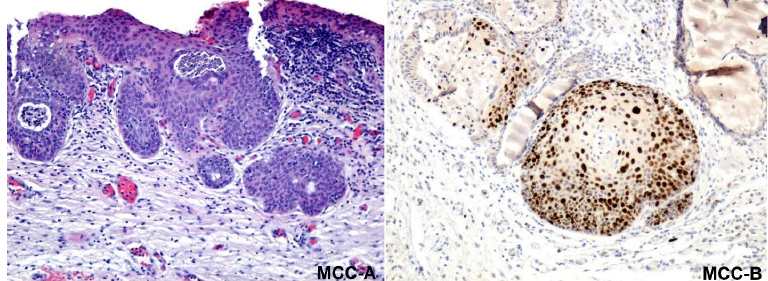
Figure 9. Microscopic aspects of microinvasive cervical cancer. MCC-A: non-keratinized stratified squamous epithelium with severe dysplastic lesions in all the tissue layers and the existence of a microinvasion island beyond the epithelial basement membrane is observed. The neoplastic cells invade the stroma, in one or more sites, to a depth of ≤ 3 mm below the base of the epithelium, without lymphatic or blood vessel involvement. Classical stained hematoxylin–eosin x100; MCC-B: the existence of an island of microinvasion immunolabeled with the anti-Ki67 antibody can be observed, which has crossed the epithelial basement membrane. MCC: microinvasive cervical cancer.